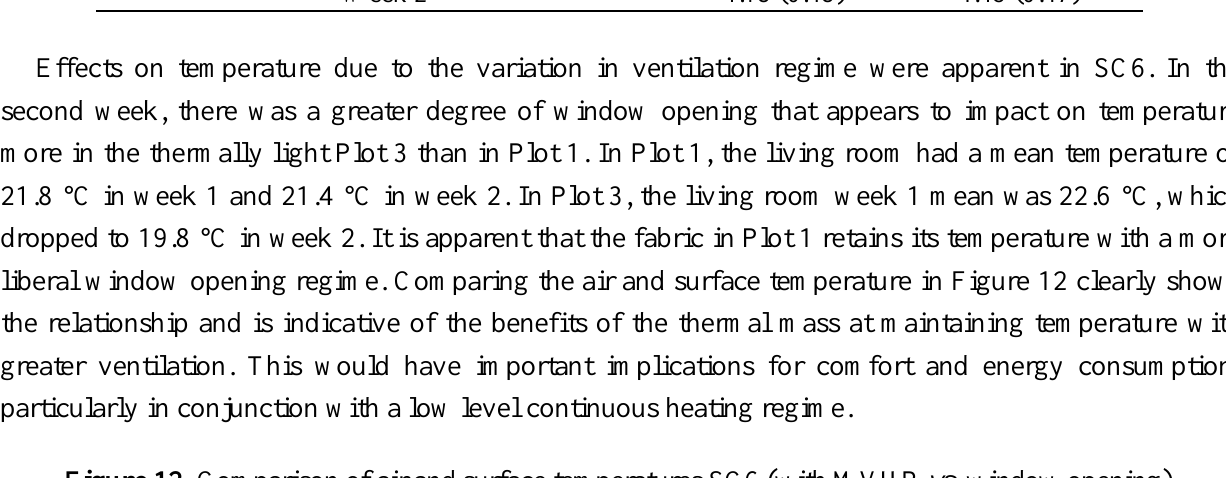
Figure 12. Comparison of air and surface temperatures SC6 (with MVHR vs. window